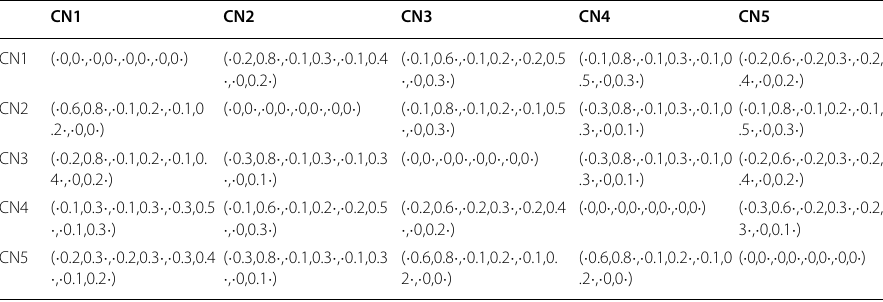
Table 16 Picture fuzzy rough sets for